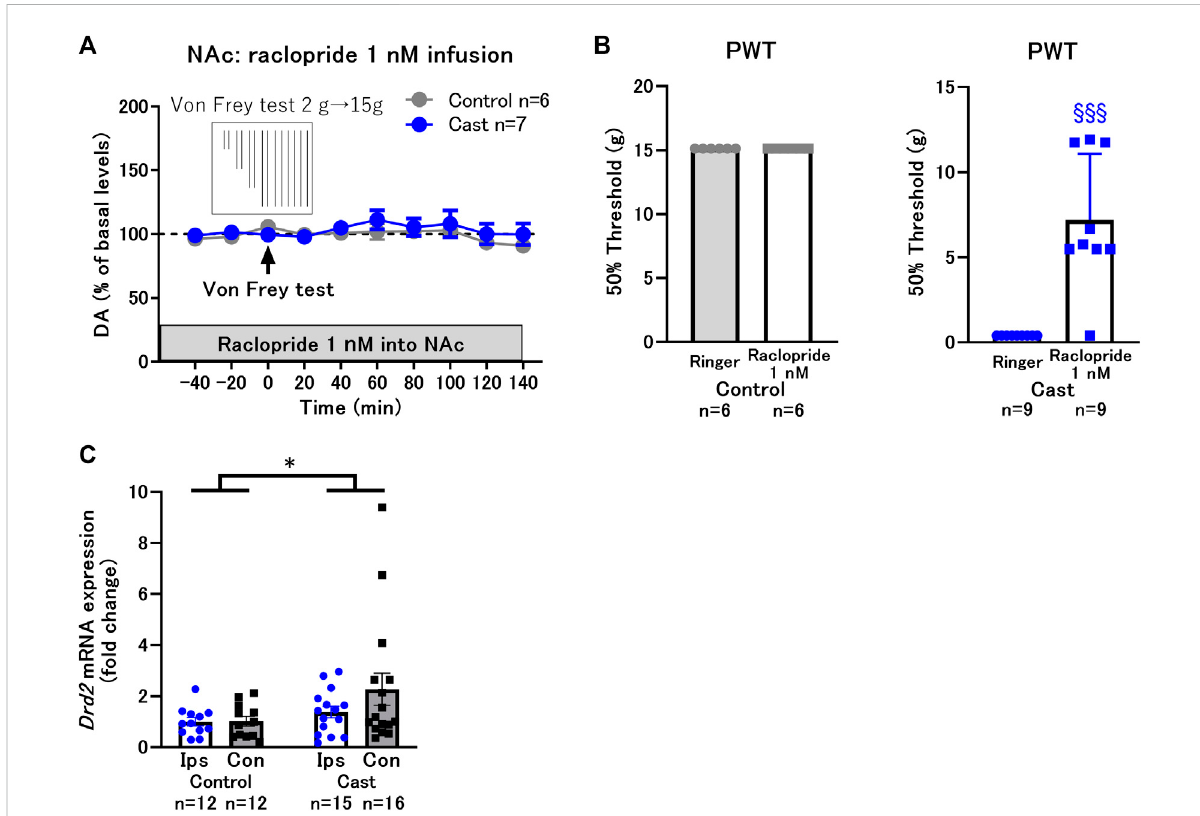
FIGURE 3 Effects of local infusion of raclopride into the nucleus accumbens shell (NAcSh) on the decreased paw withdrawal threshold (PWT) in rats with cast immobilization. (A) Effects of the von Frey test after 2 h of local infusion of raclopride at a low dose (1 nM) on DA levels in the control and cast groups. (B) Local infusion of raclopride at a low dose (1 nM) did not affect the PWT in the control group, but drastically increased it in the cast group. §§§ p < 0.001 versus the group with Ringer infusion; Welch ’ s t -test. (C) Effects of cast immobilization on the expression of Drd2 mRNA in the ipsilateral (Ips) and contralateral (Con) NAcSh. These results were obtained from different experimental groups from (A) and (B) , and did not go through the microdialysis experiments or drug infusions. Therefore, there were no tissue damages from the microdialysis probe implantations. Homogeneity of variance was evaluated with Levene ’ s test ( p = 0.1008) and the result implicate that variances are equal across groups. * p < 0.05 between the control and cast group; two-way ANOVA. Data represent mean ± SEM (A,C) and mean ± SD (B) . The number of rats is indicated in the